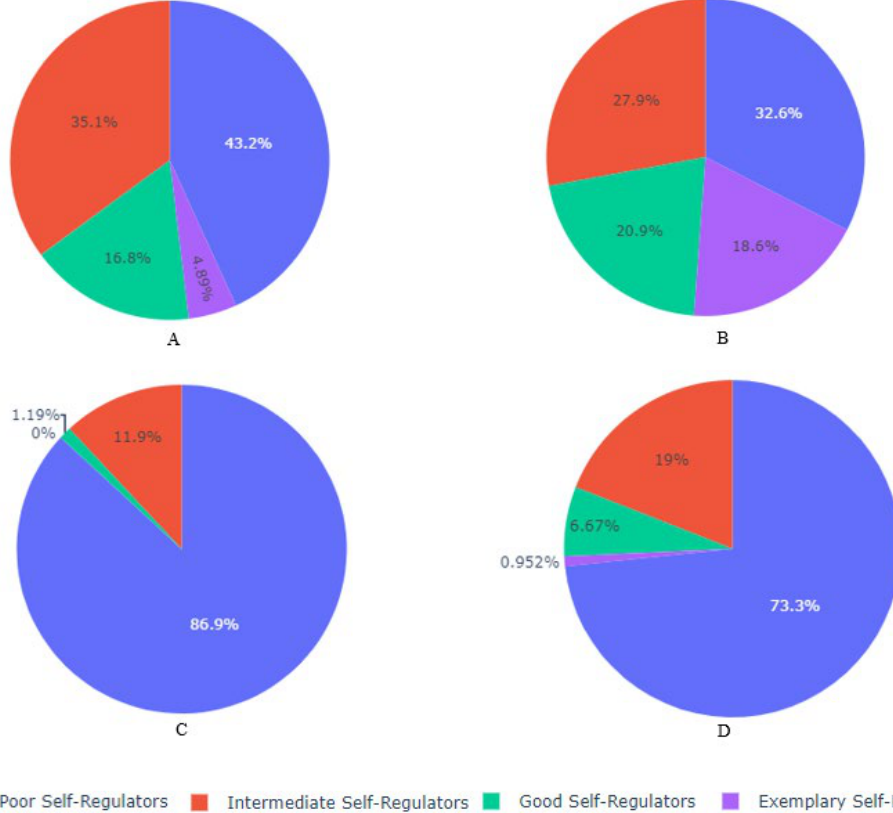
Distribution of SRL Profiles Among Students Based on Their Final